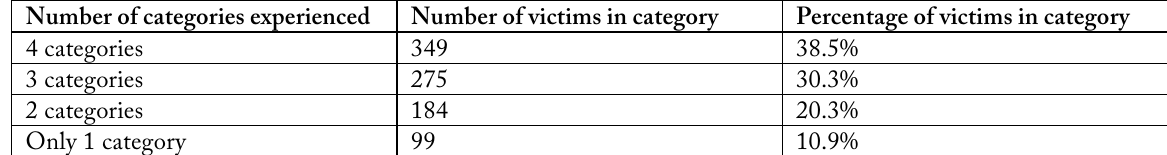
Table 2: Number of categories in which respondent-victims indicated that they experienced acts of WPB (n=907) Number of categories